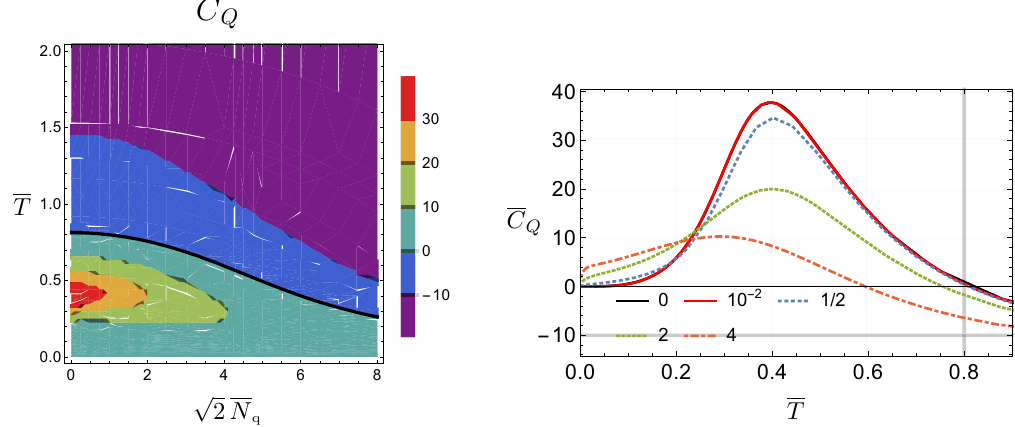
Figure 14 . (Left) Contour plot of the dimensionless specific heat (4.25). The thick black curve = 0. (Right) Dimensionless specific heat as a function of temperature indicates the locus where C Q for several fixed values of the charge density √ 2 N . Note that the black curve is hardly visible q because it falls almost exactly behind the red curve.